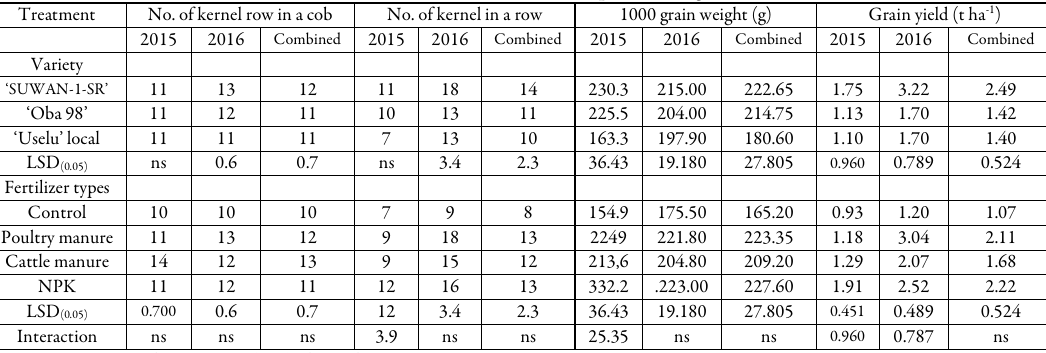
Table 3. Effects of the studied maize varieties and fertilizer types on the growth of maize Treatment No. of kernel row in a